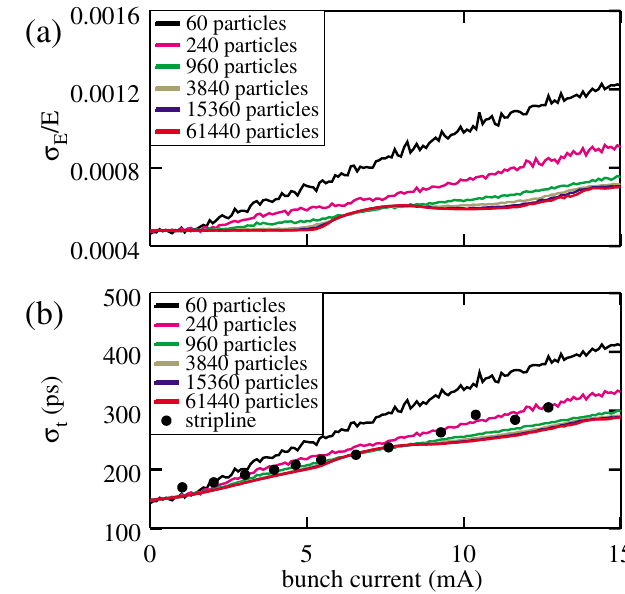
FIG. 1. (Color) The relative energy spread and rms macropar- FIG. 2. (Color) The relative energy spread and rms bunch length ticle arrival time of the Aladdin low-emittance lattice are shown of the Aladdin low-emittance lattice are shown for single-bunch for operation with all 15 rf buckets filled, with the harmonic operation with the harmonic cavity detuned. Simulated values cavity detuned. Simulated values for a parasitic impedance with =p j (cid:2) 5 : 7 (cid:3) are plotted for for a broadband impedance of j Z (cid:2) 3000 , resonant impedance R (cid:2) 10 k(cid:3) , and quality factor Q p 3 3 (cid:2) 6 : 283 19 (cid:10) 10 9 rad = s are simulations using different numbers of macroparticles. The resonant angular frequency ! 3 simulated values are averages over the final 500 000 turns of 1 (cid:10) plotted for simulations using different numbers of macropar- ticles. The simulated values are averages over the final 500 000 10 6 -turn simulations with harmonic-cavity tuning angle of (cid:4) 90 (cid:8) . Measured bunch lengths were obtained from the voltage turns of 1 (cid:10) 10 6 -turn simulations with harmonic-cavity tuning induced upon a 0.365-m strip line. angle of –90 (cid:8)